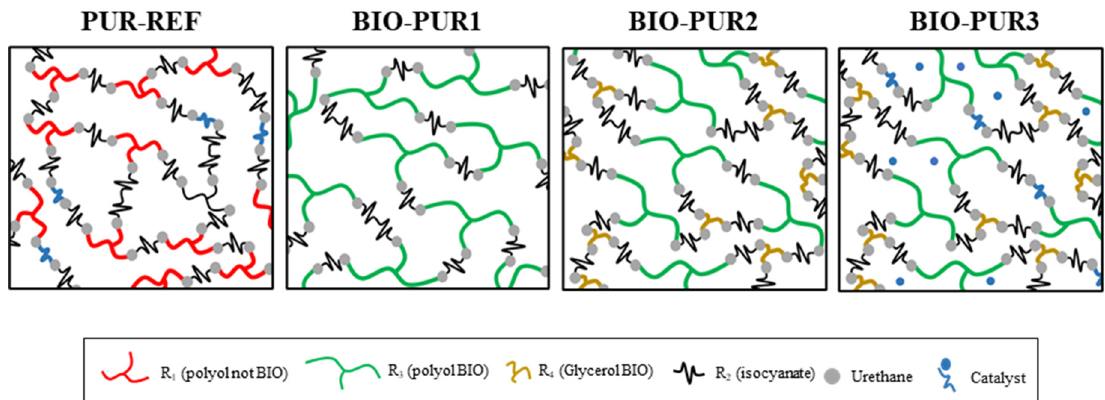
Figure 4. Scheme of PUR/BIO-PUR system three-dimensional network.